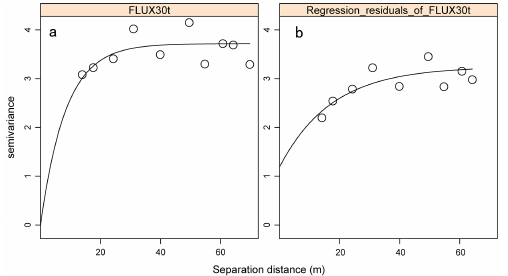
Figure 6. Semivariograms (open circles) and best-fitted models (solid lines) of the normal logit-transformed N 2 O fluxes (FLUX30t) (no dimension) for ordinary kriging (a) and the regression residuals of FLUX30t (no dimension) with chamber placement position as the predictor for regression kriging (b) .